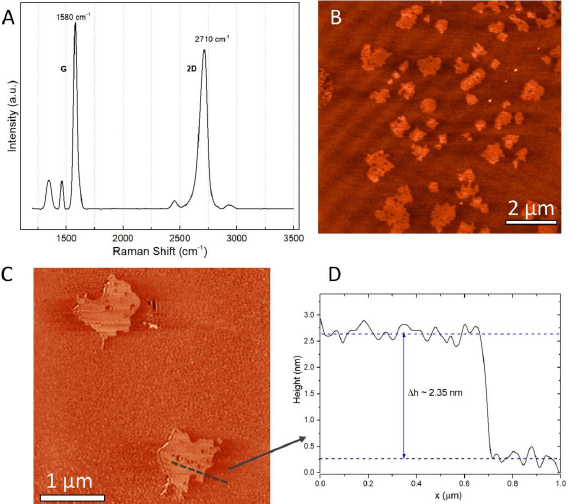
Figure 2. ( A ) Raman spectra of multilayer graphene obtained by supercritical fluid exfoliation; ( B ) AFM topography image of graphenes deposited on silicon wafer substrate, scan area 10 µm × 10 µm and ( C ) scan area 3.7 µm × 3.7 µm; ( D ) cross-section profile evidencing a multilayer graphene thickness of approximately 2.35 µm.